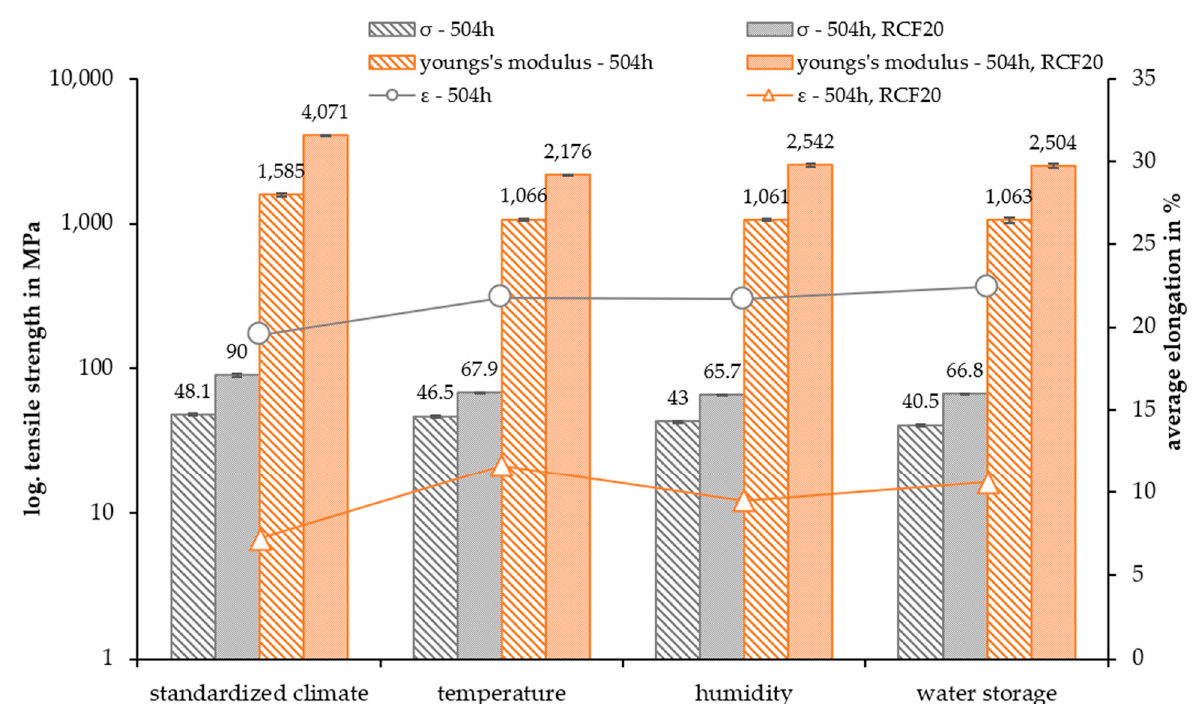
Figure 12. Tensile strength, Young’s modulus, and average elongation of the accelerated-aged test specimen after 504 h.